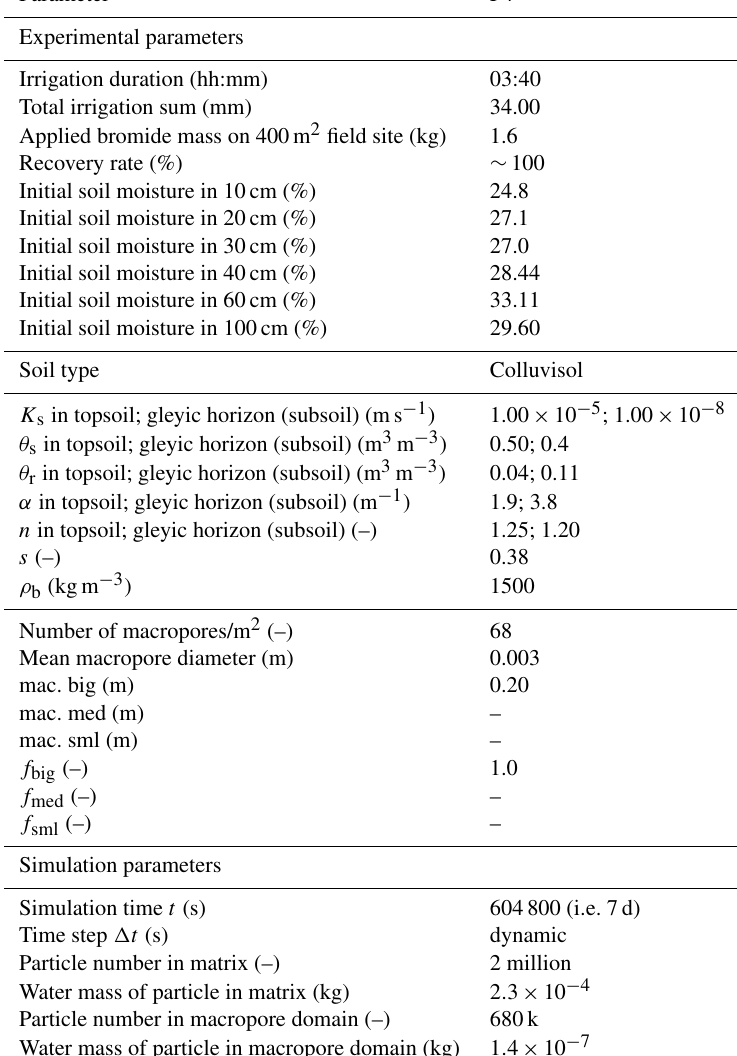
Table 3. Parameters of 7d bromide experiment at the plot-scale site (site P4) (Klaus et al., 2014) and simulation parameters as well as soil hydraulic parameters according to van Genuchten (1980) and Mualem (1976). For parameter definitions and further details on these parameters, see caption of Table 1 and Sternagel et al. (2019). Note that only one macropore depth of 15cm was observed at this